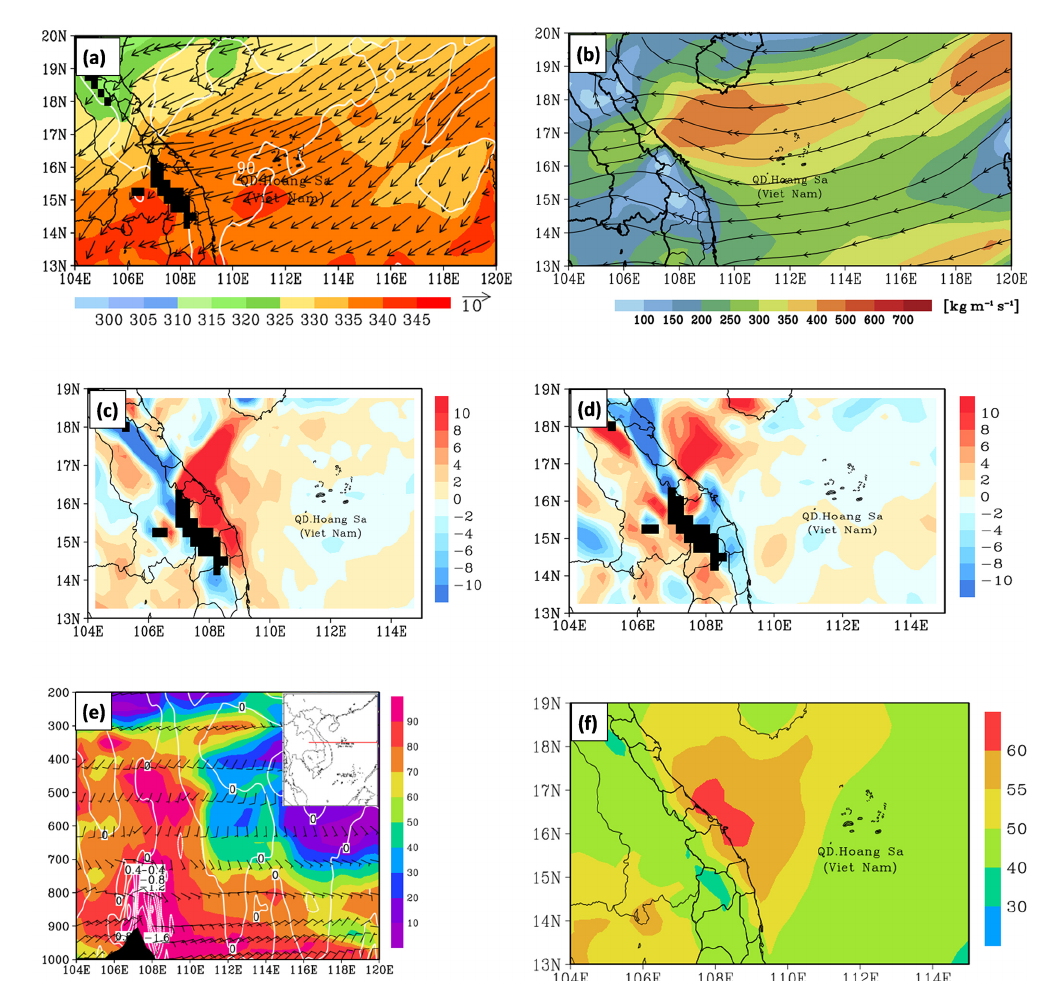
Figure 10. As in Fig. 9, except for 12:00UTC on 9 December